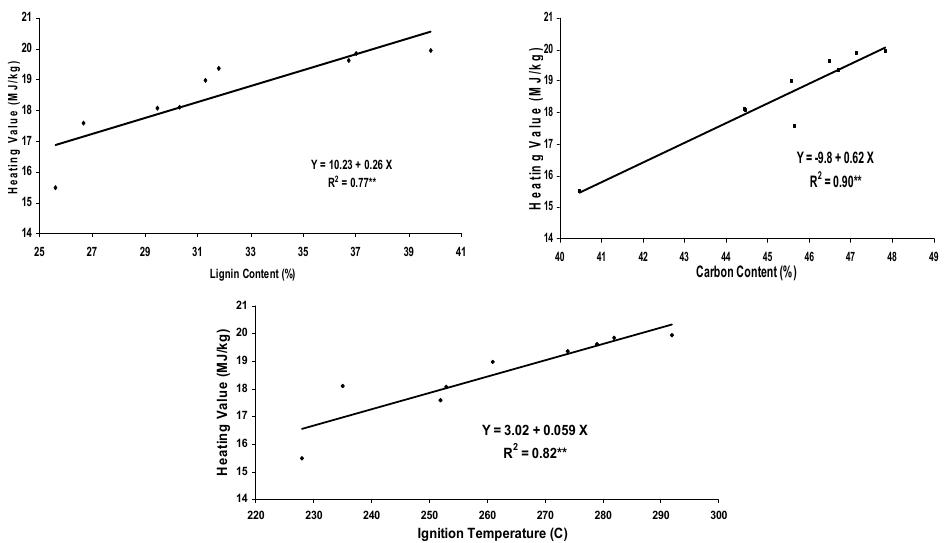
Figure 2. Relationship between heating value and lignin content, carbon content and ignition temperature of date palm residues. ** Significant at 0.01 level of probability.